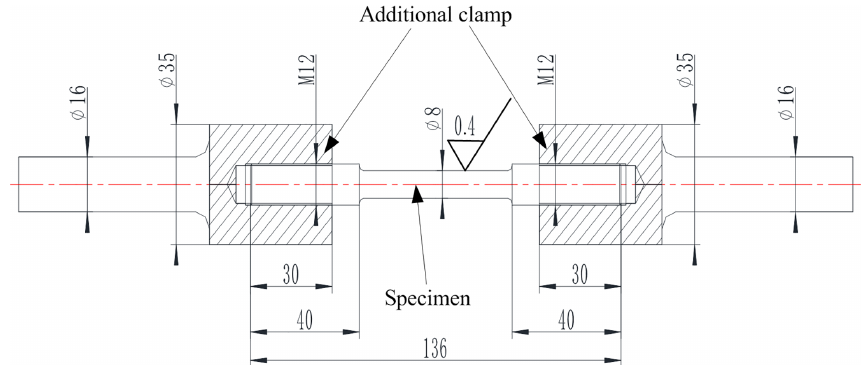
Figure 2. Specimen geometry and additional clamp of static tensile tests (dimensions in